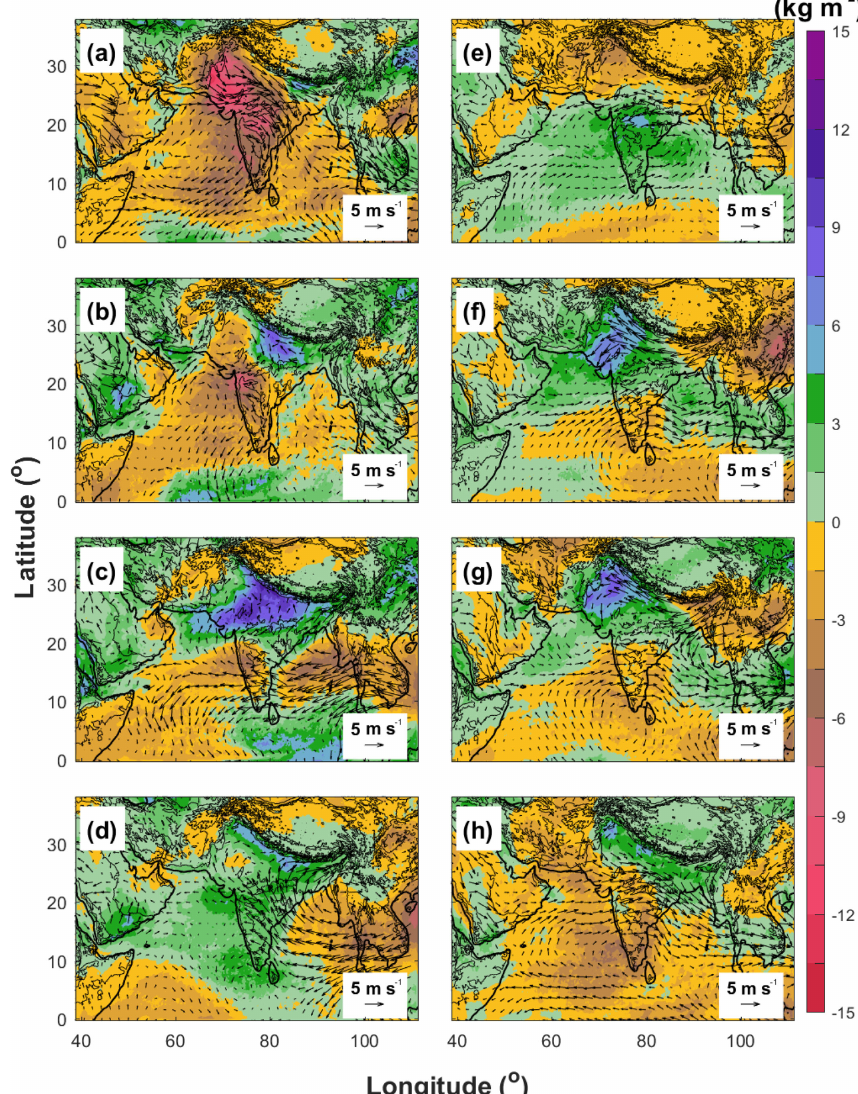
Figure 15. Phase composites of 850hPa wind and precipitable water anomalies obtained from WRF-gray ( a–h : Phase 1 to 8).